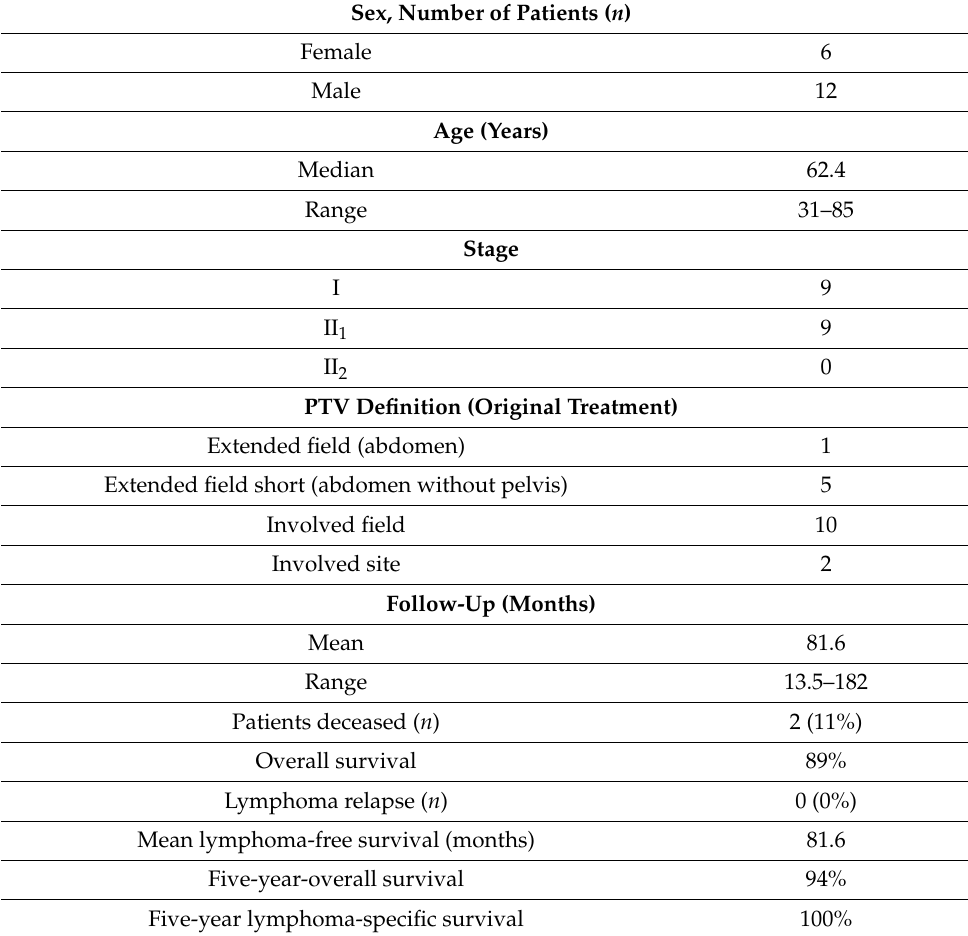
Data of the 18 included patients showing information on demographic data, original radiation field, and survival parameters. Two patients died during follow-up time, and no patient showed lymphoma progress. n = number, PTV = planning target